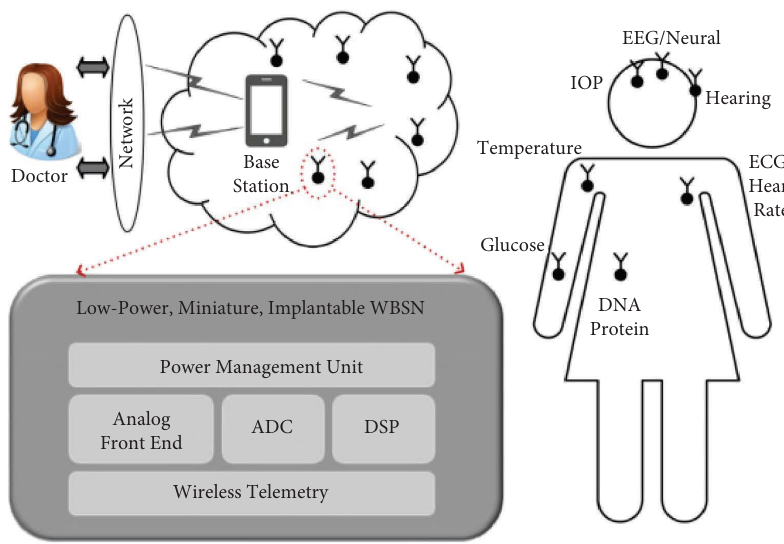
Figure 1: Wireless body sensor nodes forming